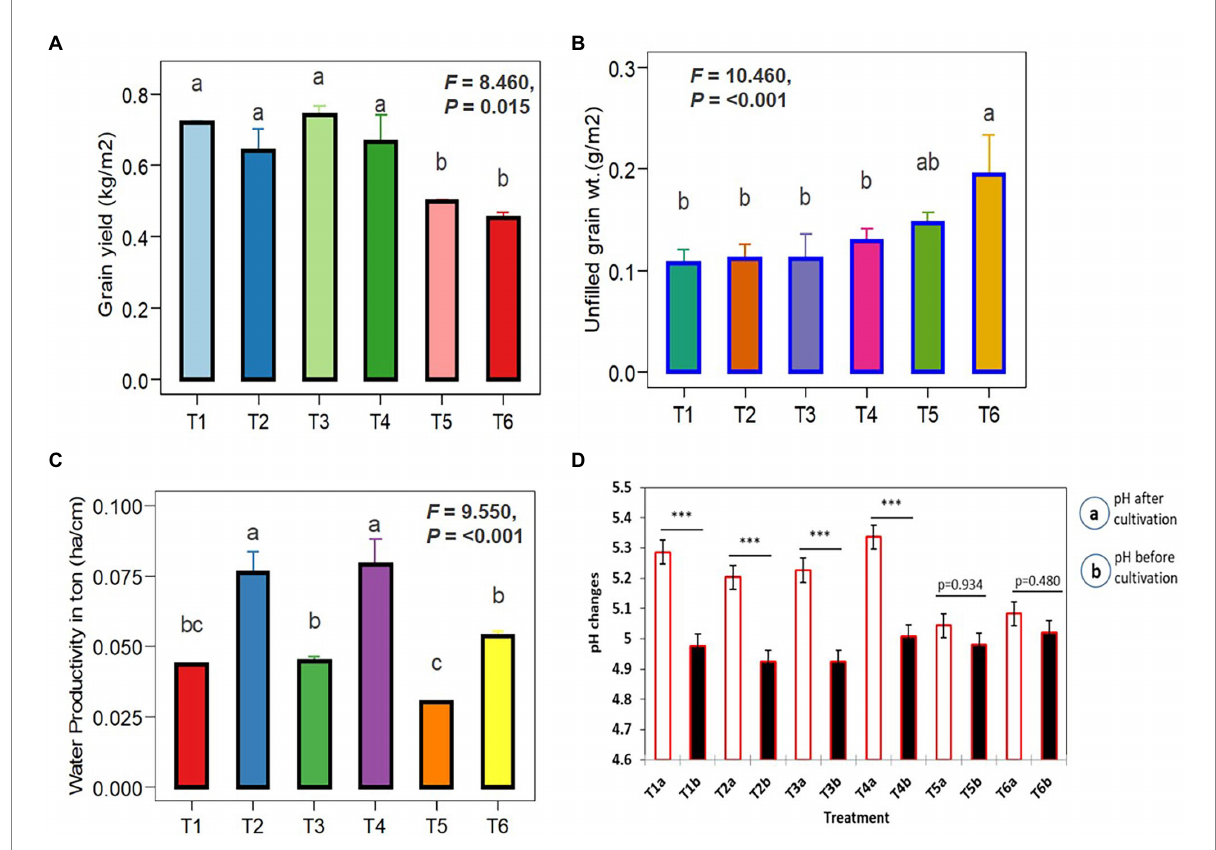
FIGURE 7 One-way ANOVA illustrates the influence of Trichoderma spores with SI under different cultivation conditions. (A) Filled grain yield per m 2 . (B) Unfilled grain yield per m 2 . (C) Water productivity under CP (T1, T3, and T5) and AFW (T2, T4 and T6). (D) pH changes before and after inoculation ( Trichoderma + SI) was compared by pairwise comparison (ns p ≥ 0.05, * p < 0.05, ** p < 0.01, *** p < 0.001). Data are means ± SD ( n = 5). Bars without shared letters indicate significant differences according to Tukey’s HSD